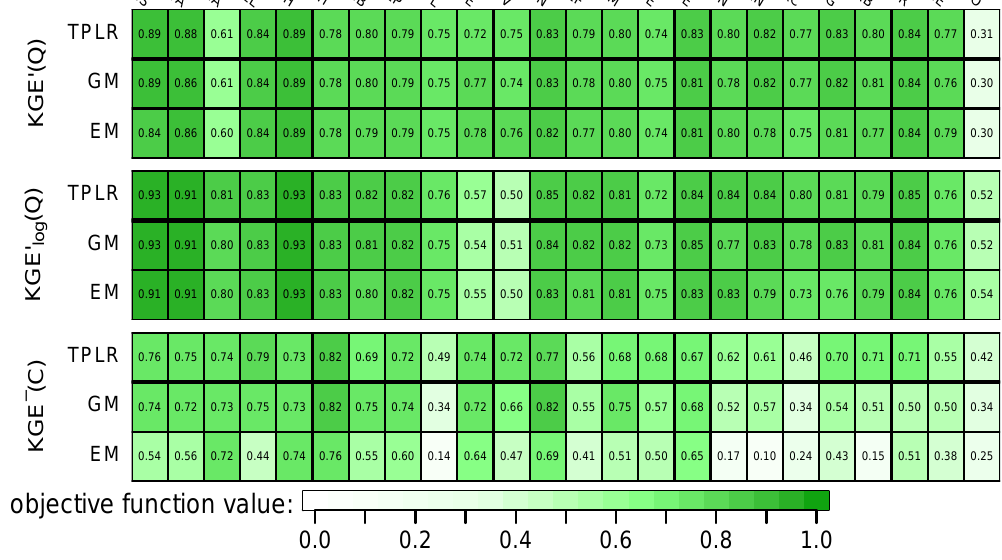
Figure 4. Values of the three objective functions for all catchments for the three different TF